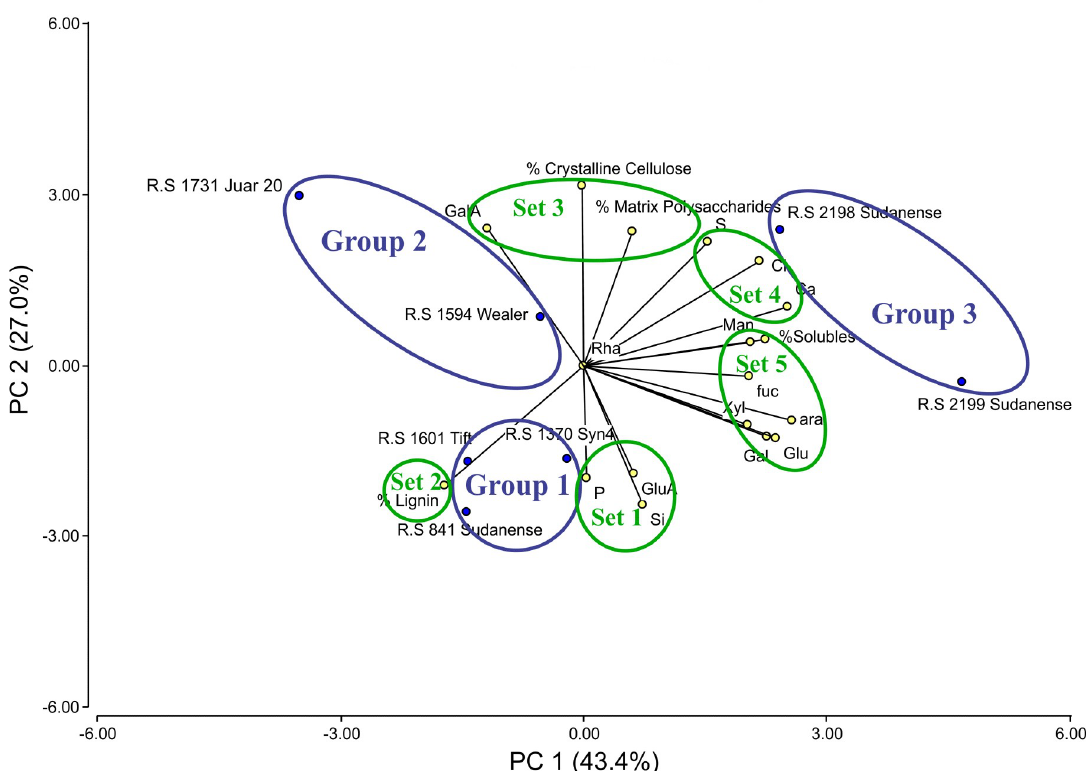
Fig 7. Principal component analysis for major cell wall polymers, monosaccharides, and agronomic parameters in seven sudangrass accessions. Sets (1, 2, 3, 4, and 5) of variables are encircled in green solid lines and groups (1, 2, and 3) of sudangrass accessions are encircled in blue solid